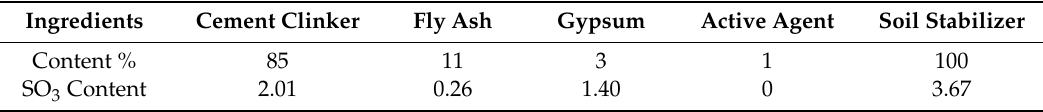
Table 1. Soil stabilizer ingredients and SO 3 content in the